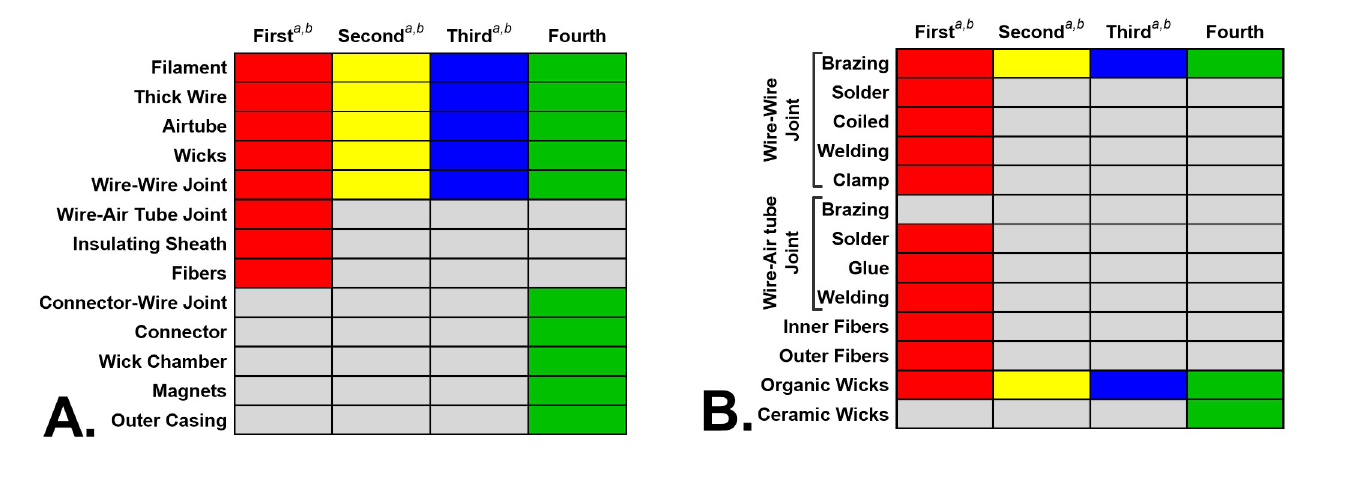
Fig 8. Atomizer components, methods of joining, and types of component in four EC generations. (A) Atomizer components in four EC generations. (B) Types of joining methods, fibers, and wicks in four EC generations. The columns indicate the four EC generations (first = cartomizers/disposables, second = clearomizers/tanks, third = mods, fourth = pods). The y-axis lists major atomizer components. a = Williams et al. 2019a; b = Williams et al. 2019b.